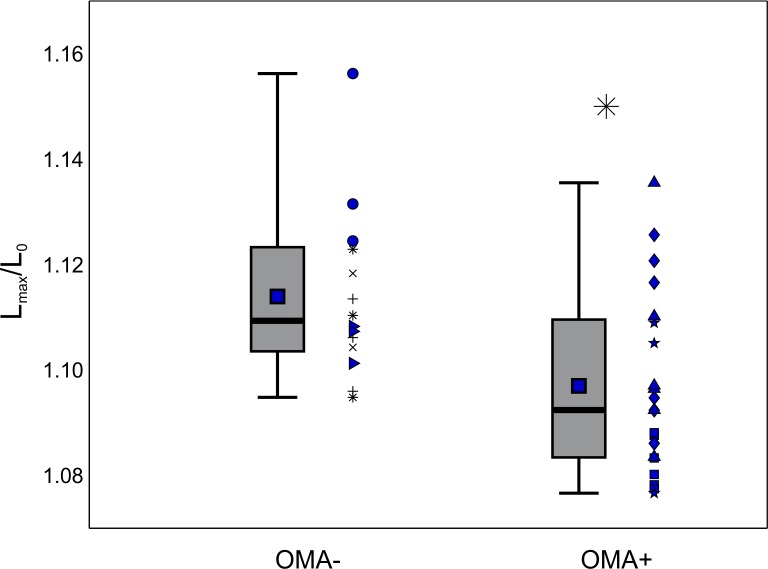
Effect of participant on observed maximum stretching ratio.The top and bottom of the lightly shaded rectangles indicate the 25th and 75th quartiles, respectively, the thick black bars indicate the median, the dark square markers indicate the mean, and the whiskers represent the maximum and minimum values observed. Each marker shape corresponds to a particular individual; repeated markers denote trial replicates with blood drawn from that same participant. All samples are fasting samples only. The total number of cells observed: nOMA- = 1156, nOMA+ = 1955. Asterisk (*) indicates p<0.05.